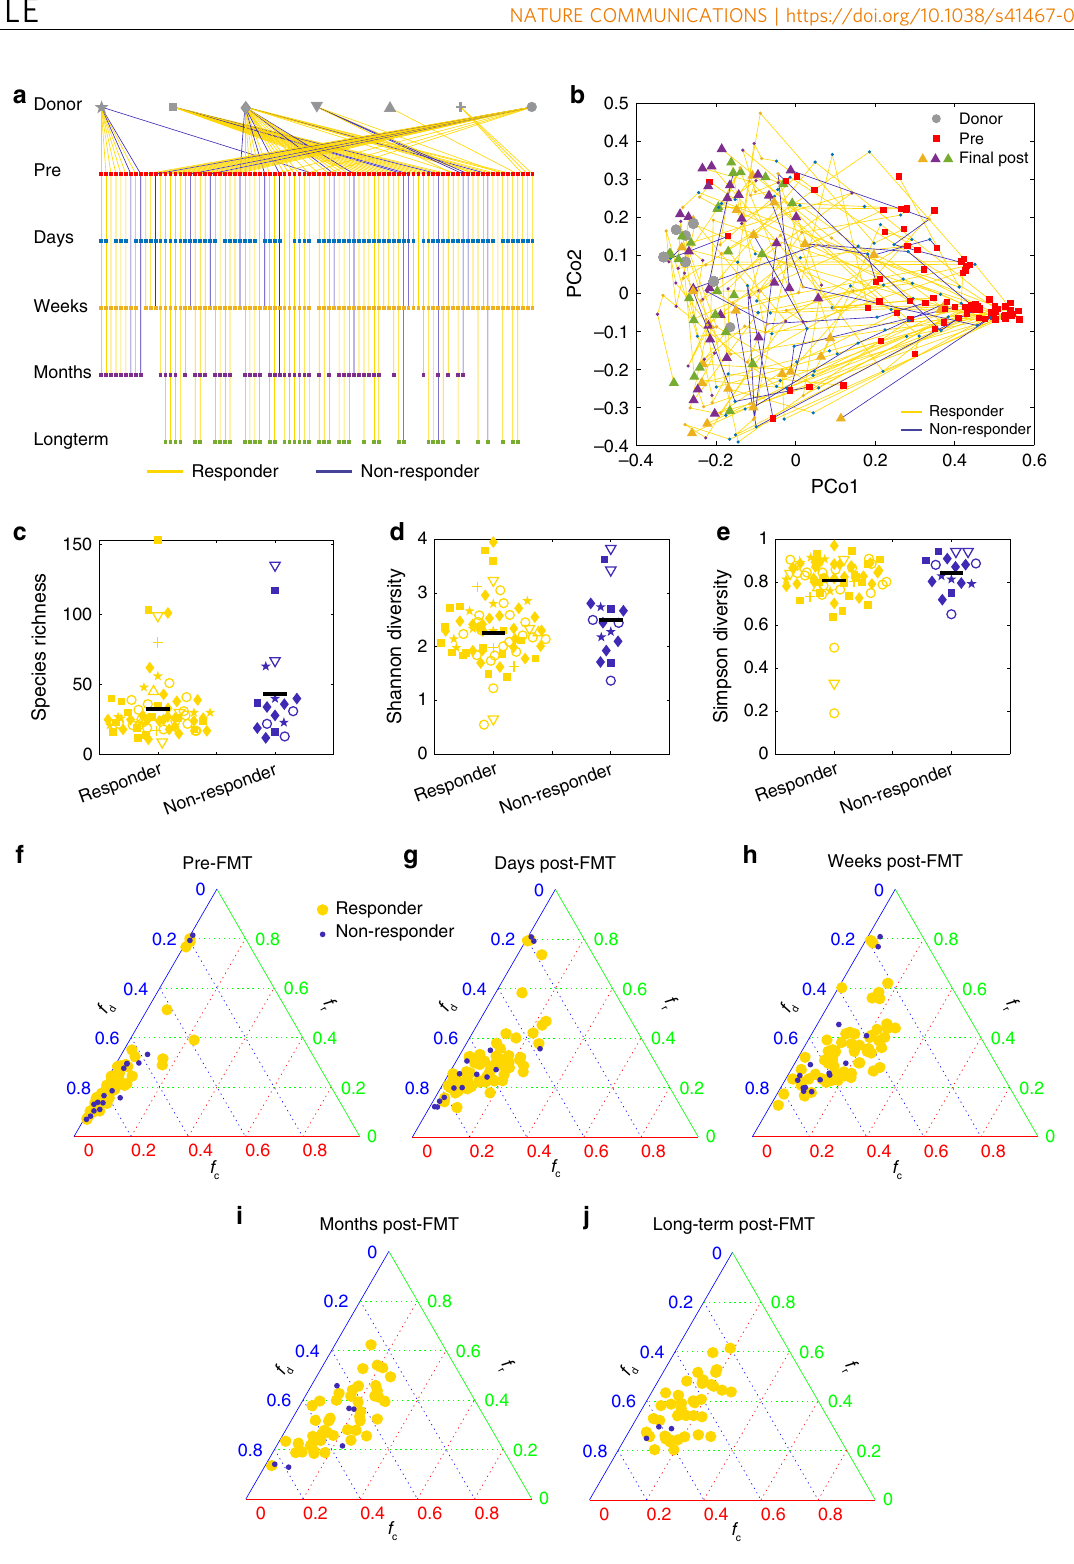
C. dif fi cile (i.e., species-5: R. obeum and species-12: K. oxytoca ). As shown in Fig. 9d (green curve), this cocktail R global can strongly suppress the abundance of C. dif fi cile . Note that